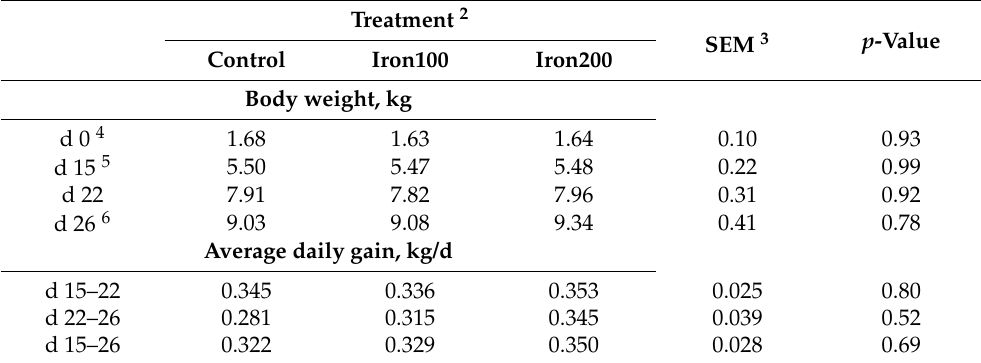
Table 1. Preweaning growth performance of pigs injected with additional iron before weaning in Experiment 1 1 .